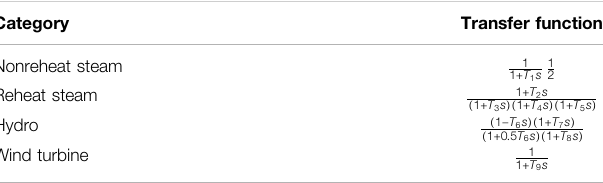
TABLE 1 | Transfer function.